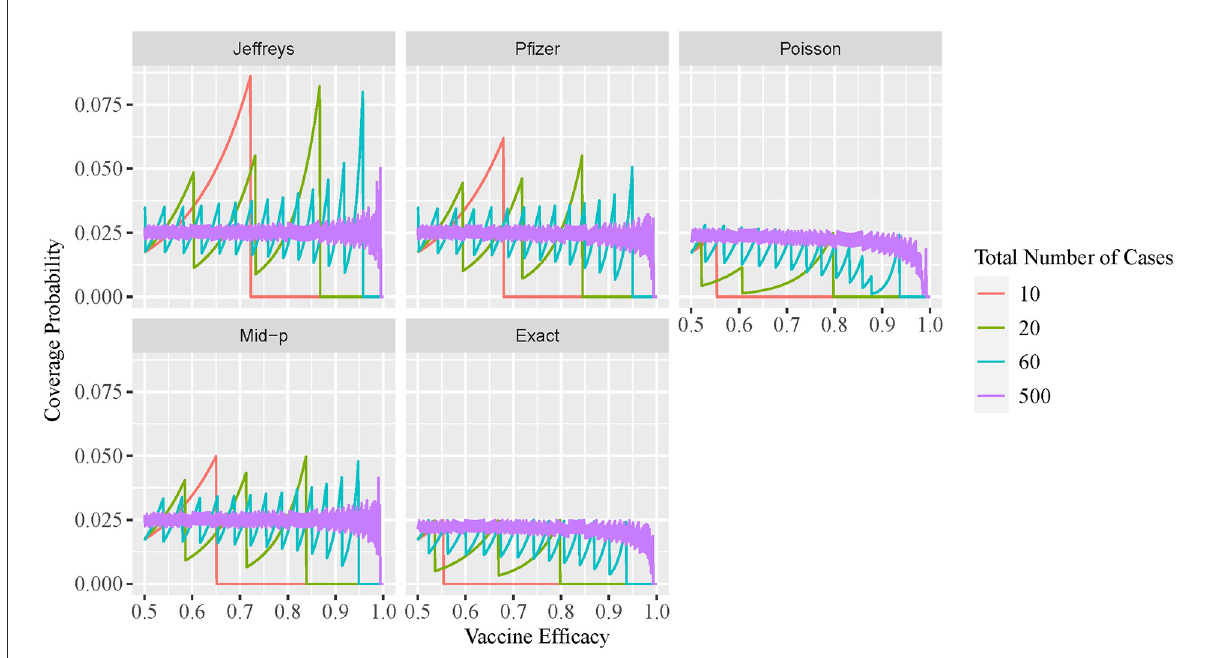
FIGURE2 Line plot of non-coverage probability at lower tail for different VE